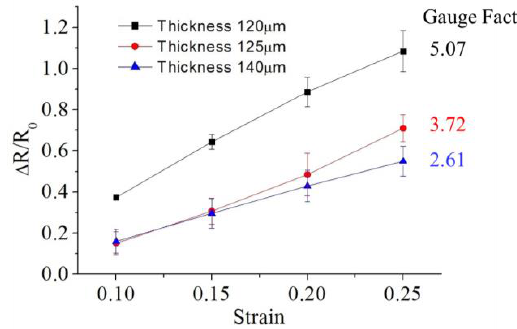
Figure 11. Effects of strain gauge thickness on gauge factor. Squares, gauge factor for the 120 μm gauge sensor; circles, gauge factor for the 125 μm gauge sensor; triangles, gauge factor for the 140 μm gauge sensor.